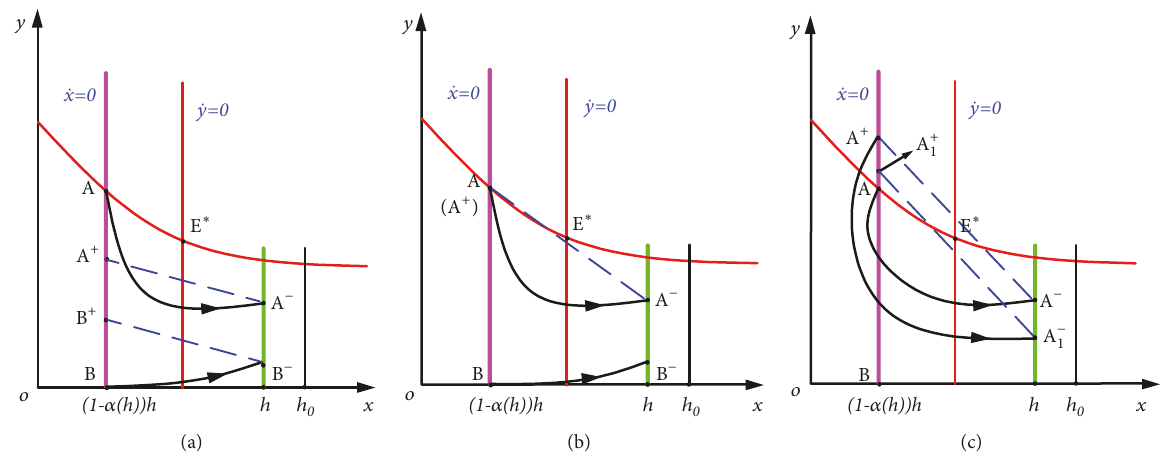
Figure 4: The existence of the OOPS of system (7) if ℎ < ℎ 0 in Case (II).